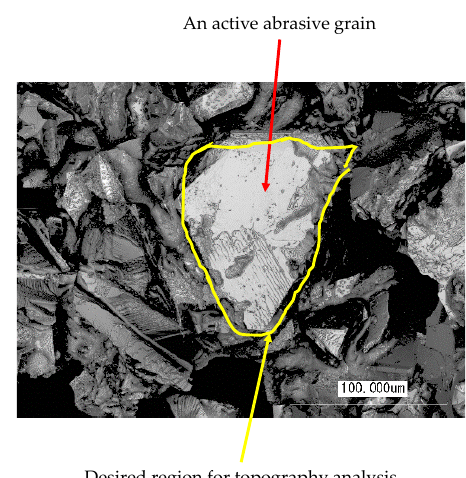
Figure 1. Image dataset preparation.